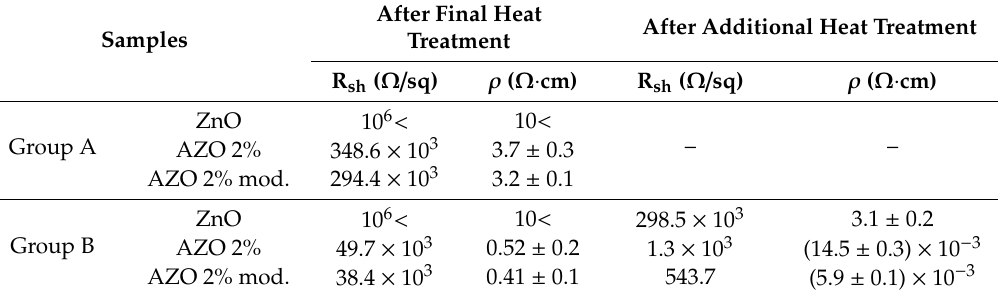
Table 4. The results of the four-point probe test on sheet resistance and resistivity values Group A (upper section) and Group B (lower section). After Final Heat After Additional Heat Samples Treatment